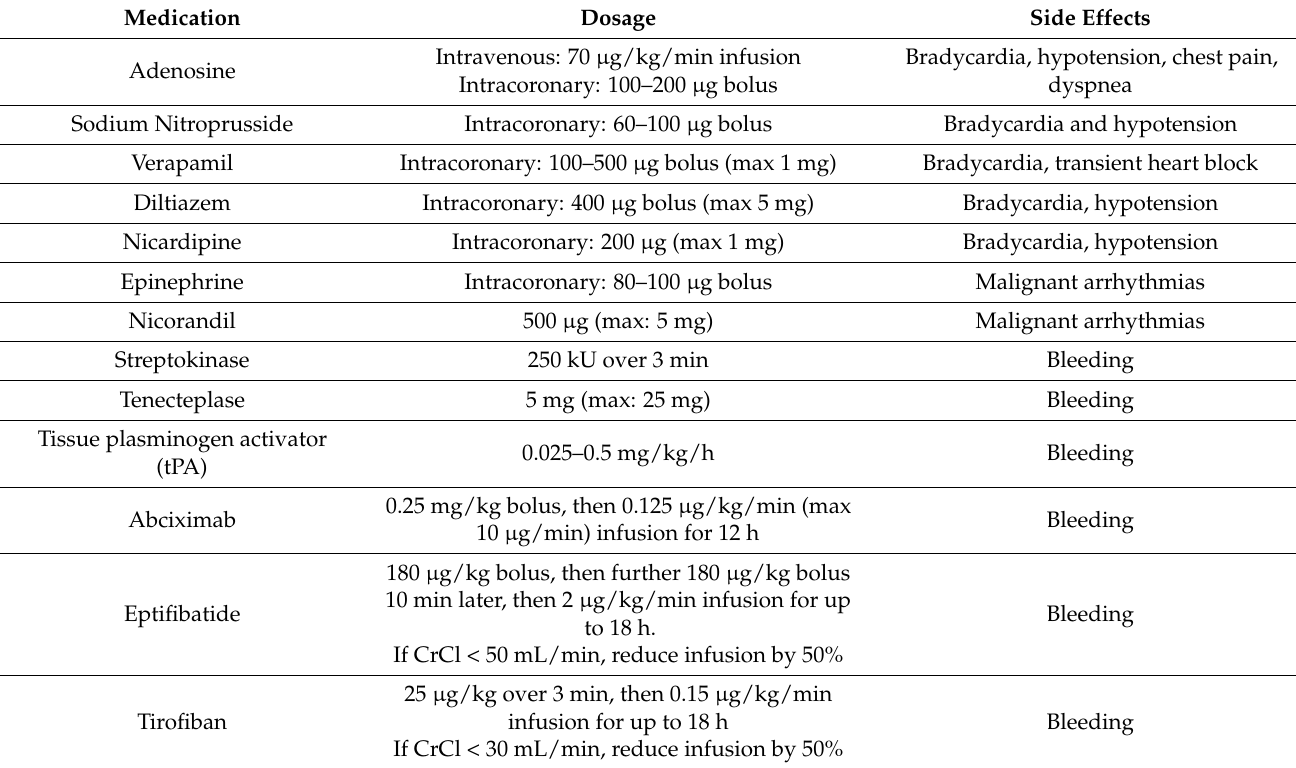
Table 2. Main drugs and dosages for the treatment of